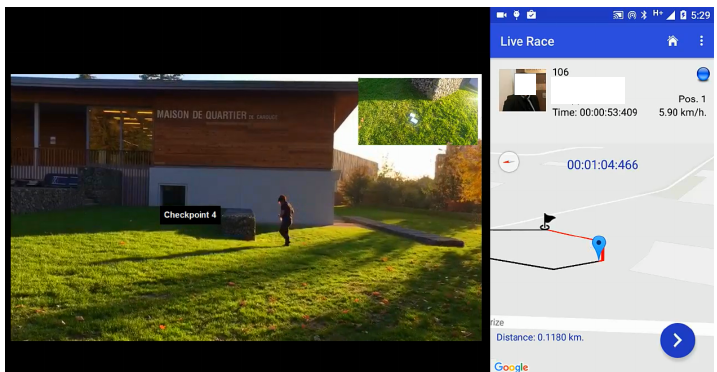
Figure 16. Tracing and visualising